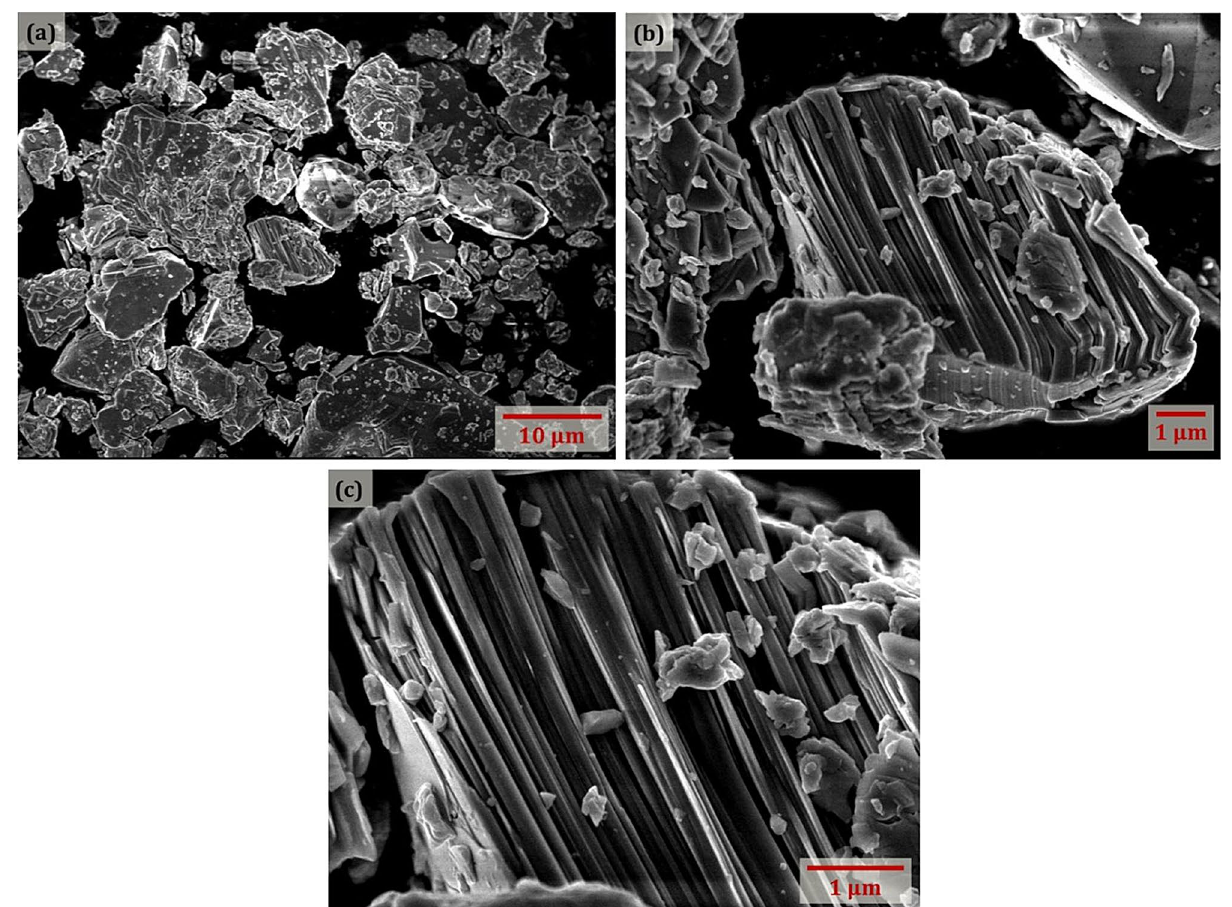
Figure 2. FESEM images of Ta 2 AlC MAX Phase captured at ( a ) 5k, ( b ) 10k, and ( c ) 20k× magnification with 5.0 kV of operating voltage.